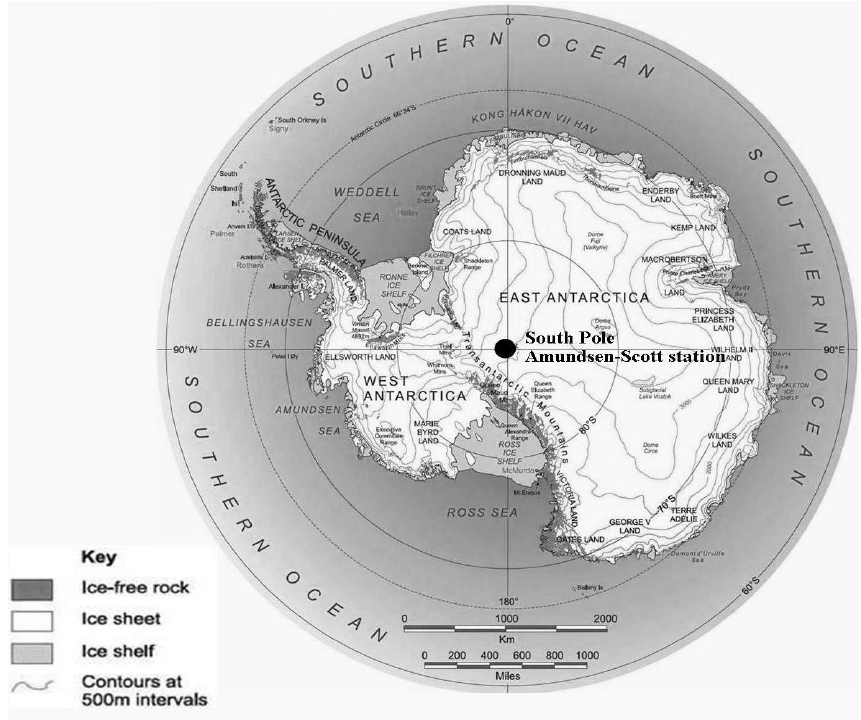
Fig. 1. Location of the Amundsen-Scott station at the South Pole, in Antarctica, marked in black circle (Geology, 2010 with modification). nucleate ice at temperatures very close to the homogeneous nucleation temperature ( − 42.2 ± 0.3 ◦